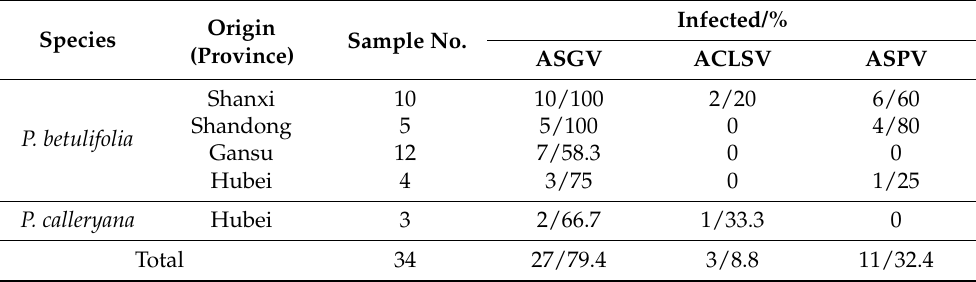
Table 1. The infection statues of three viruses in maternal trees of P. betulaefolia and P. calleryana from different locations.